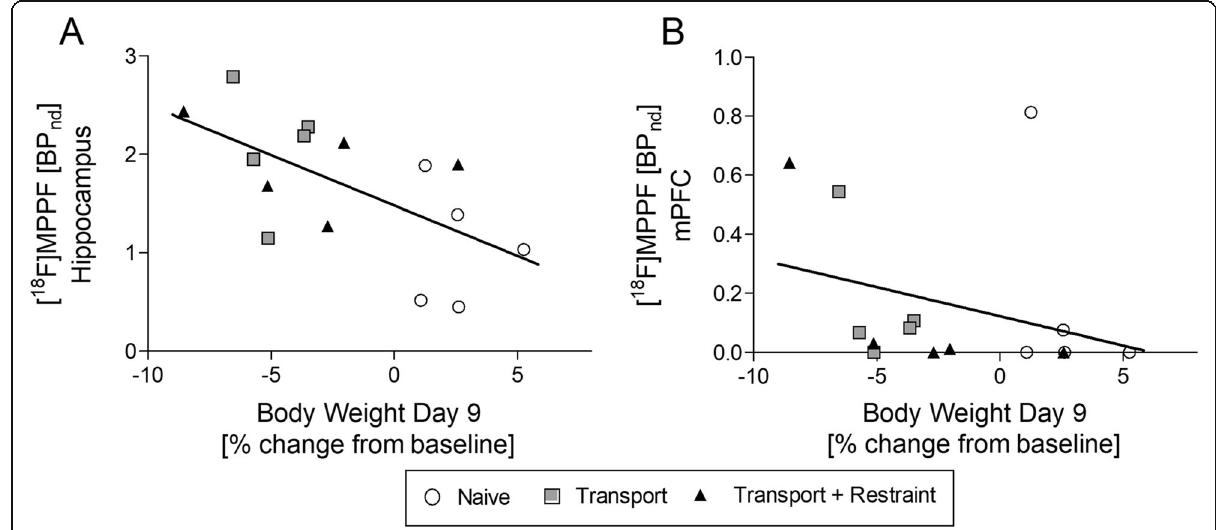
Fig. 4 Spearman correlation between body weight at day 9 and [ 18 F]MPPF binding in the hippocampus ( a ) and the medial prefrontal cortex ( b